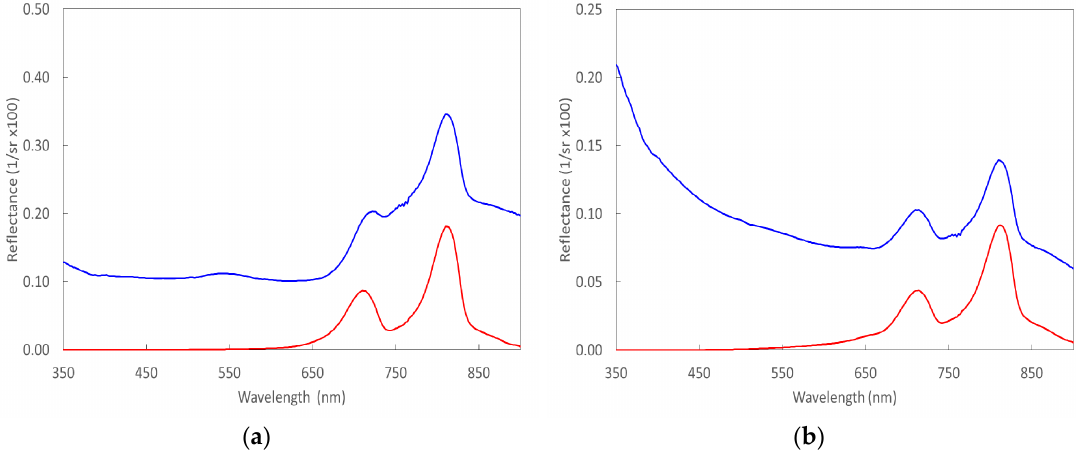
Figure 2. Reflectance spectra of extreme CDOM-rich lakes Nohipalu Mustjärv ( a ) and Meelva ( b ). The reflectance spectra shown with blue line were measured with both L u and E d sensor above the water surface. The reflectance spectra shown with red line were measured putting the radiance sensor surrounded with plastic tube a few centimetres below the water surface (reflectance without glint).